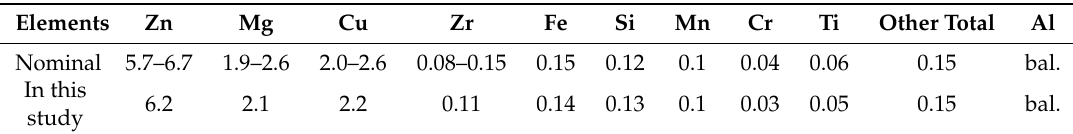
Table 1. Chemical composition of 7075 alloy (wt.